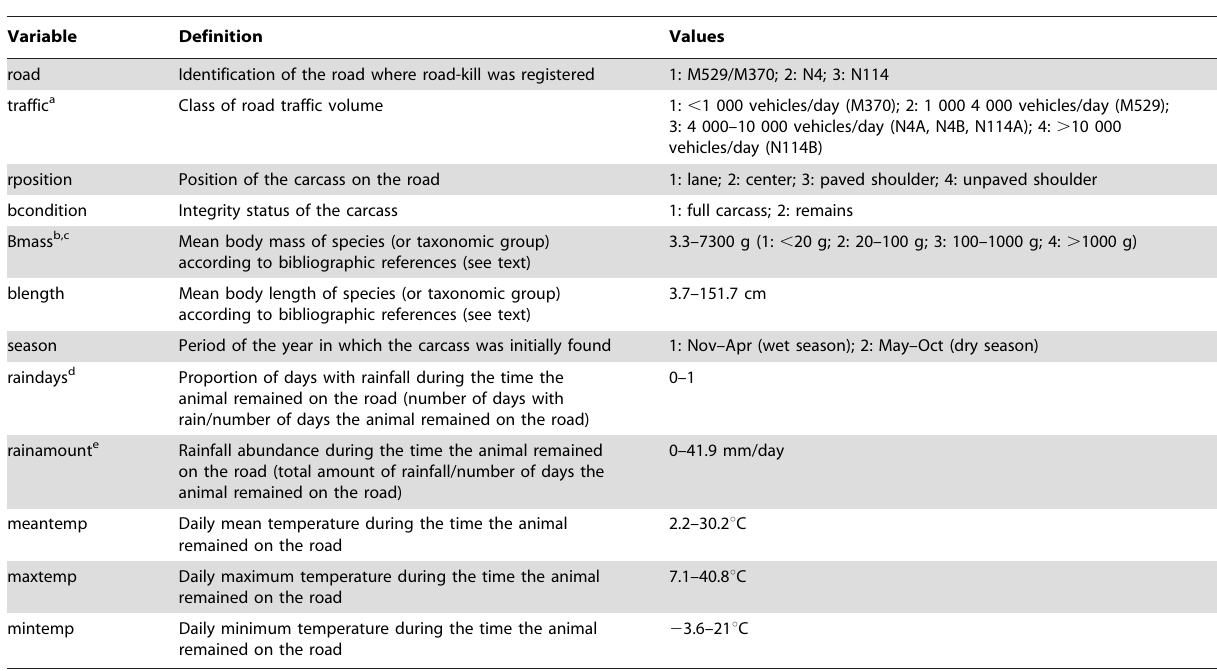
Table 8. List of explanatory variables, their definition, and